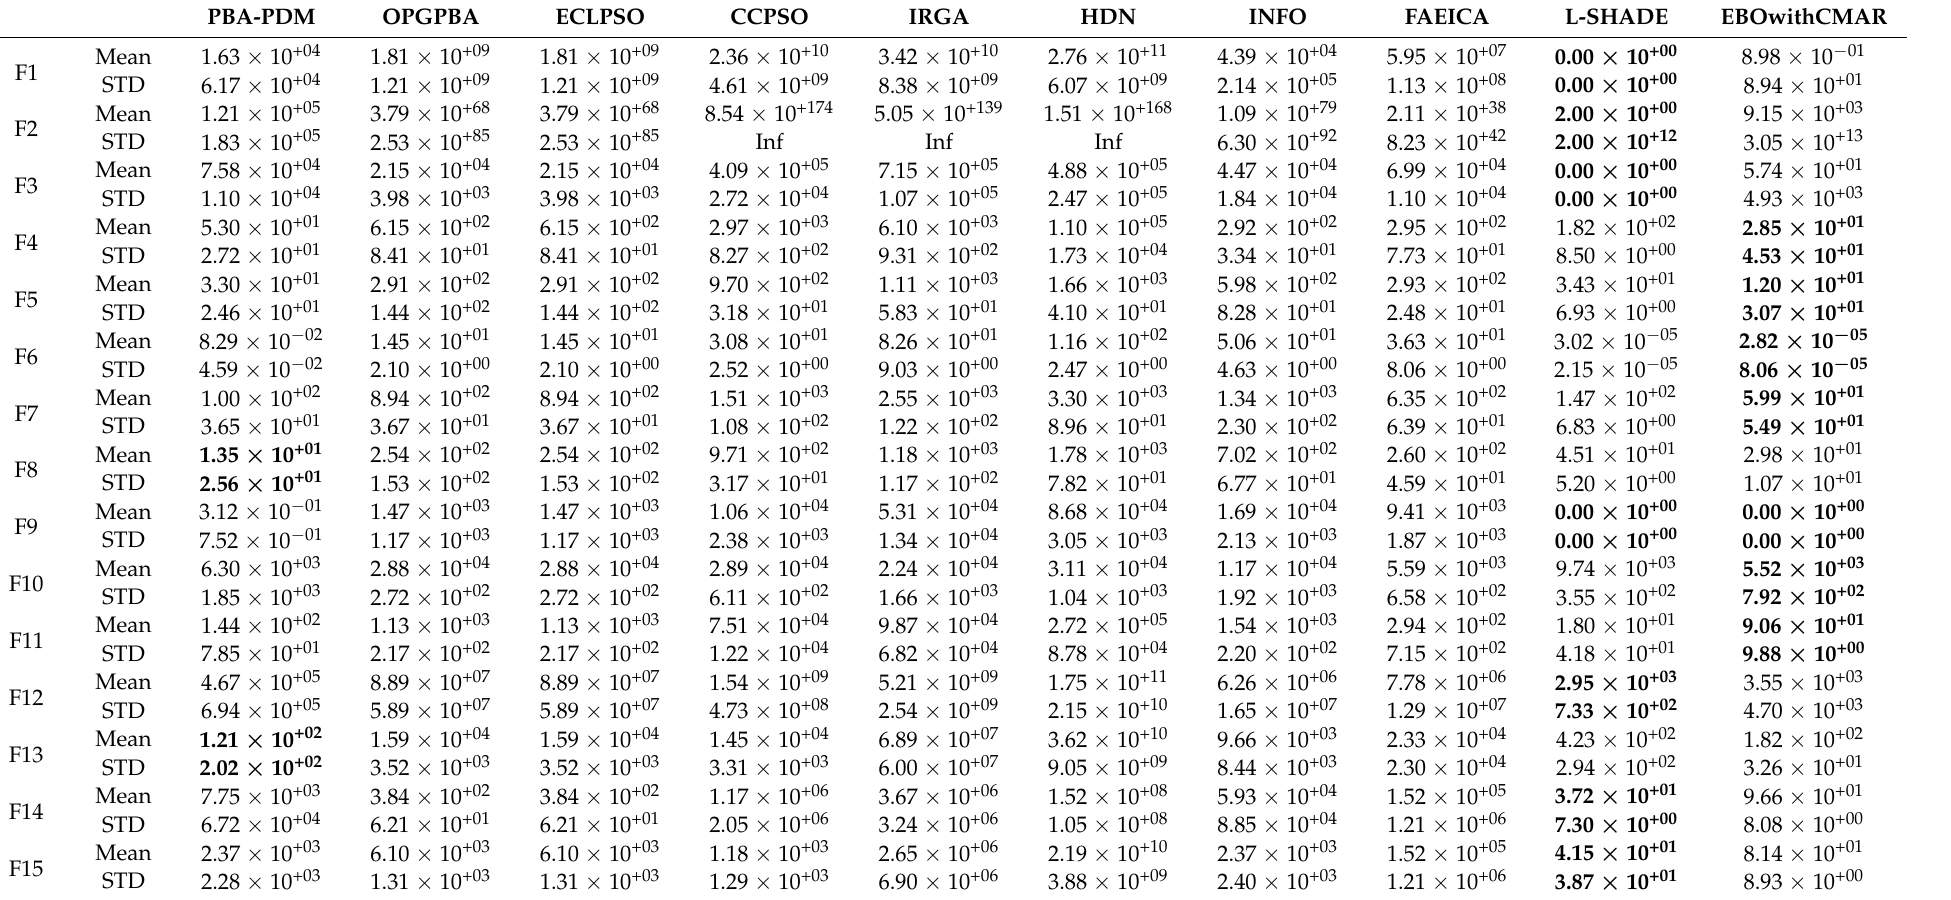
Table 9. Comparative results of the CEC2017 benchmark test functions in 100